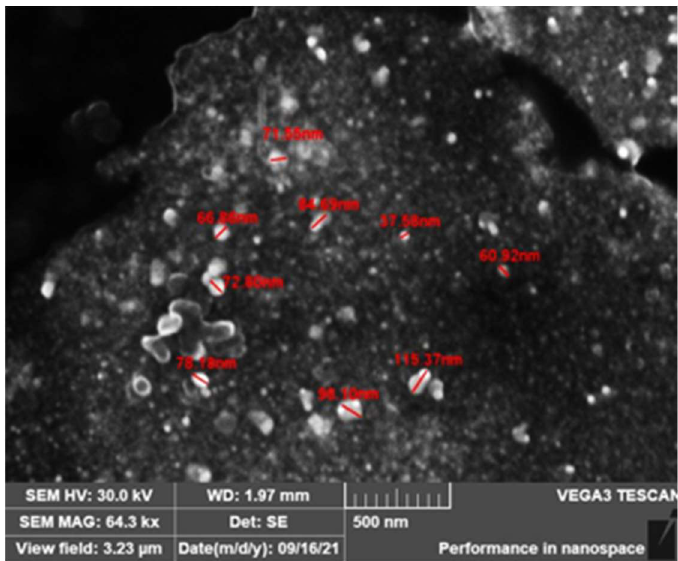
Nanomaterials 2023 , 13 , x FOR PEER REVIEW Figure 10. Scanning electron microscopy image of silver NPs. Figure 10. Scanning electron microscopy image of silver NPs.